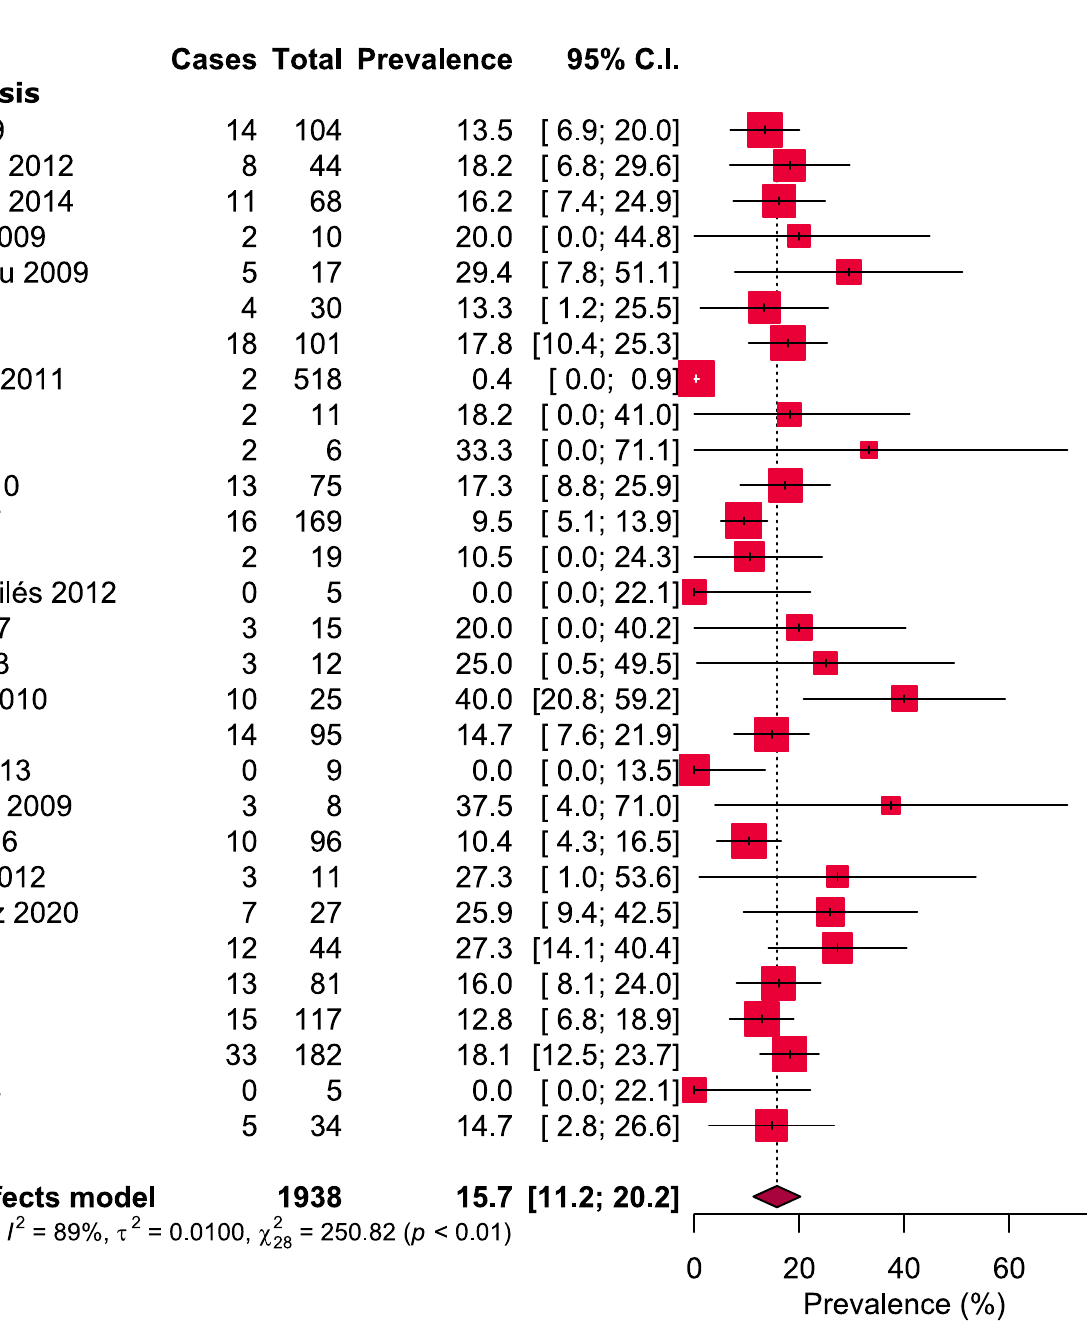
Figure 2. ( A ) Prevalence of TET2 gene mutations in patients with MPN (overall). ( B ) Prevalence of TET2 gene mutations in patients with PV. ( C ) Prevalence of TET2 gene mutations in patients with ET. ( D ) Prevalence of TET2 gene mutations in patients with MF.